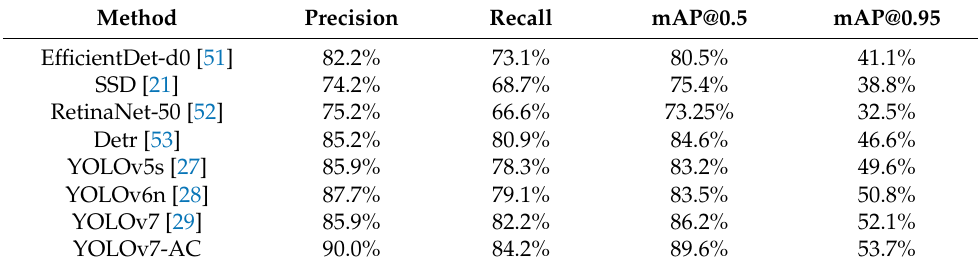
Table 3. Performance comparison of target detection model on the URPC dataset.